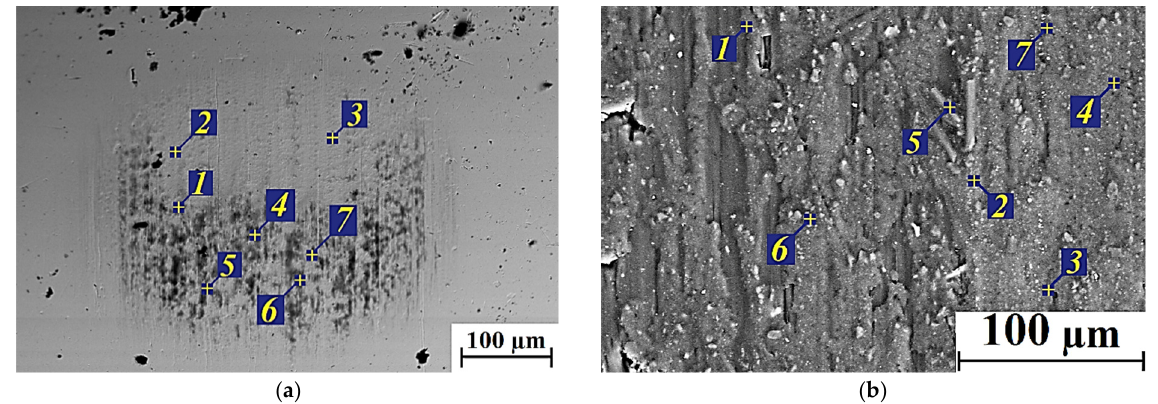
Figure 7. SEM micrographs of the steel counterpart surface ( a ) and the tribological layer on the PEI/10CCF/1HNT nanocomposite ( b ). Point tribological contact. Digits in blue squares denote Spectra numbers in Table 4.